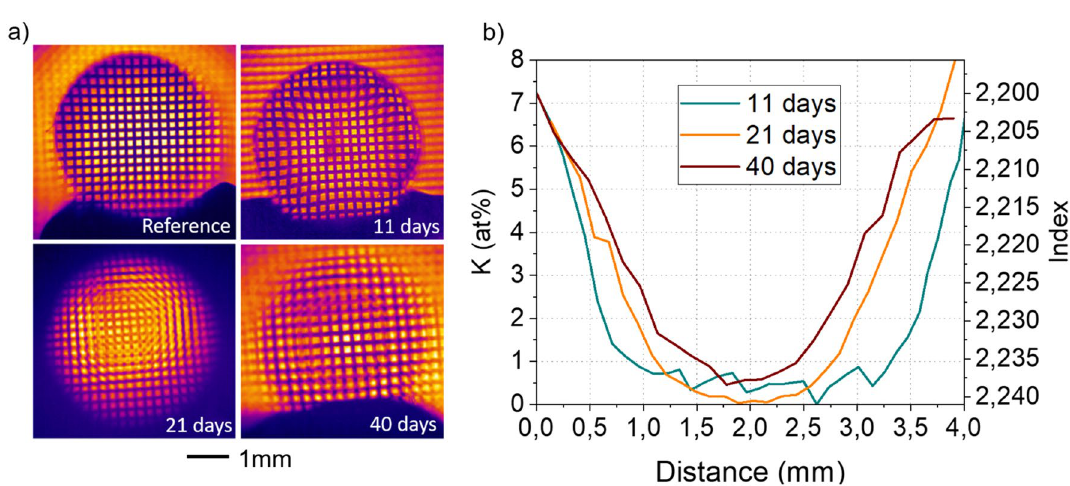
Figure 7. ( a ) GRIN lenses obtained by ionic exchange and ( b ) their respective potassium concentration and index